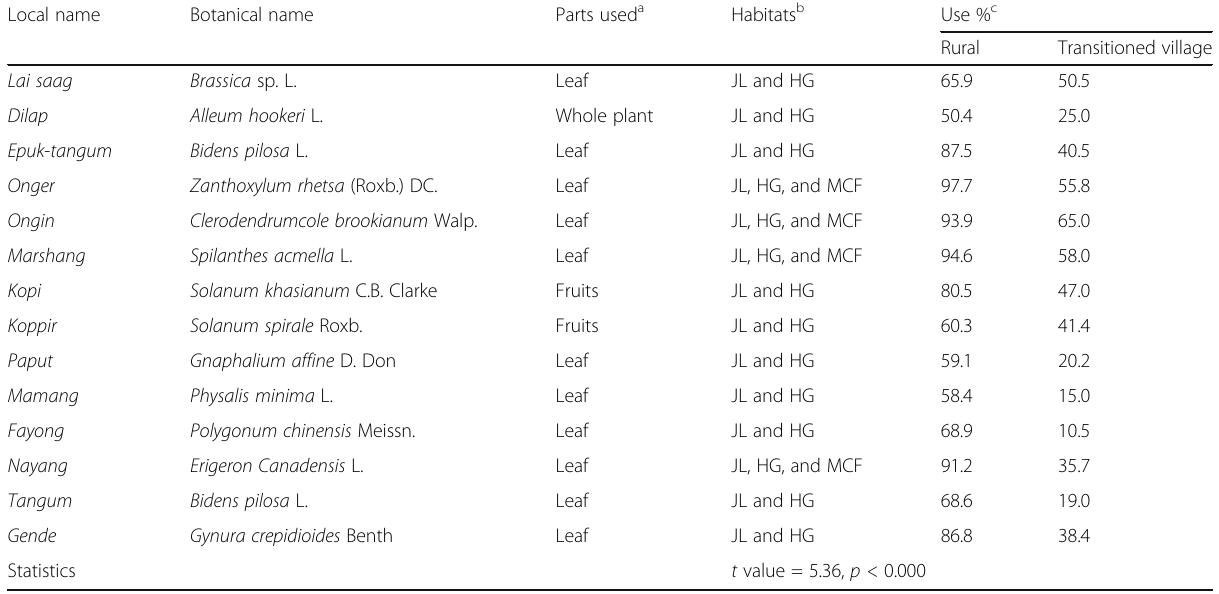
Table 1 Major local plants species used in